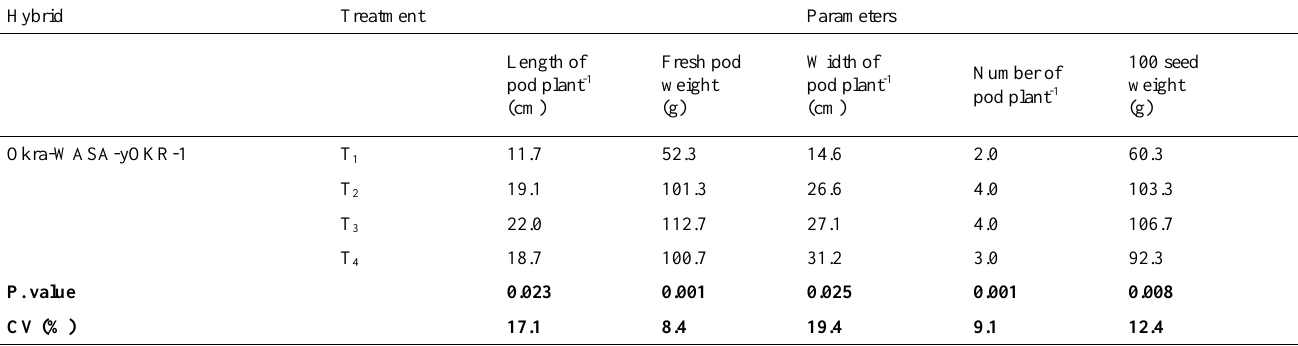
Figure 2. Mean values of vegetative parameters as affected by fertilizer application (okra-wasa-hyokr-2). Table 2. Mean values of yield components parameters as affected by fertilizer